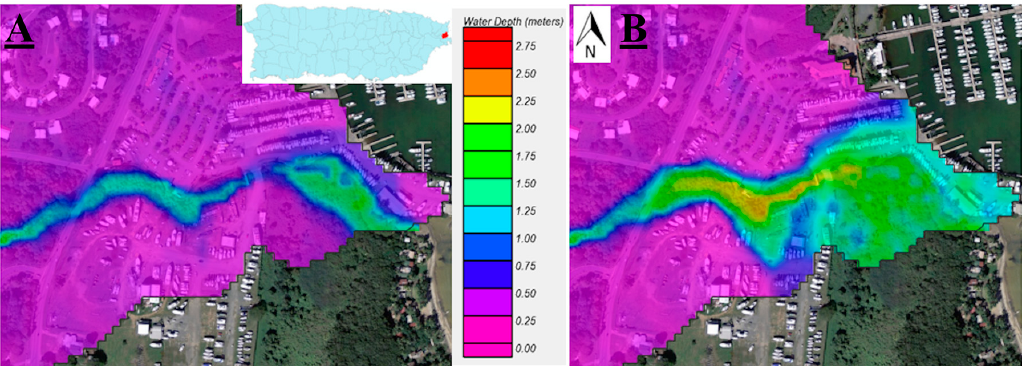
Figure 11. Maximum flood depth for the different flooding scenario at the Demajagua River watershed. ( A ) Without storm surge inland penetration; ( B ) Considering storm surge inland penetration. The color scale represents the water depth in meters, where the red color indicates the maximum value and the magenta color represents the minimum value.